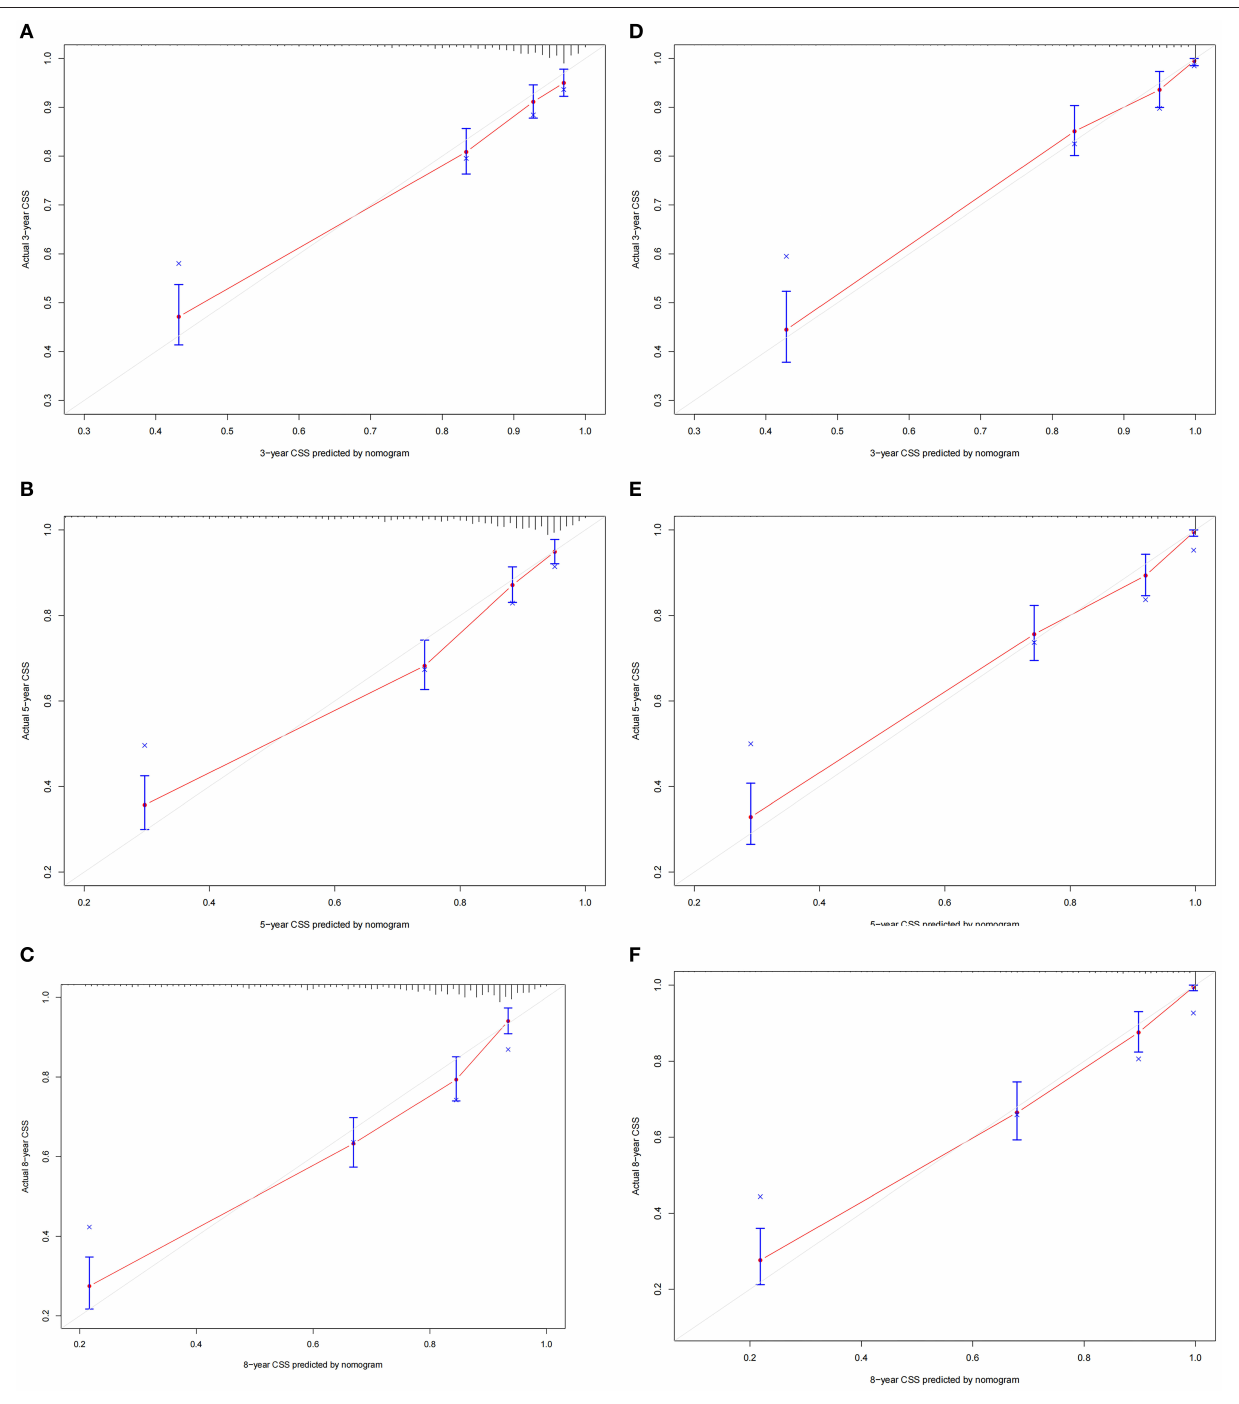
patients with surgery have a higher survival rate than those without